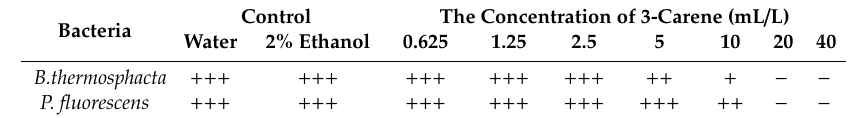
Table 1. Minimum inhibitory concentration (MIC) of 3-carene against Brochothrix thermosphacta and Pseudomonas